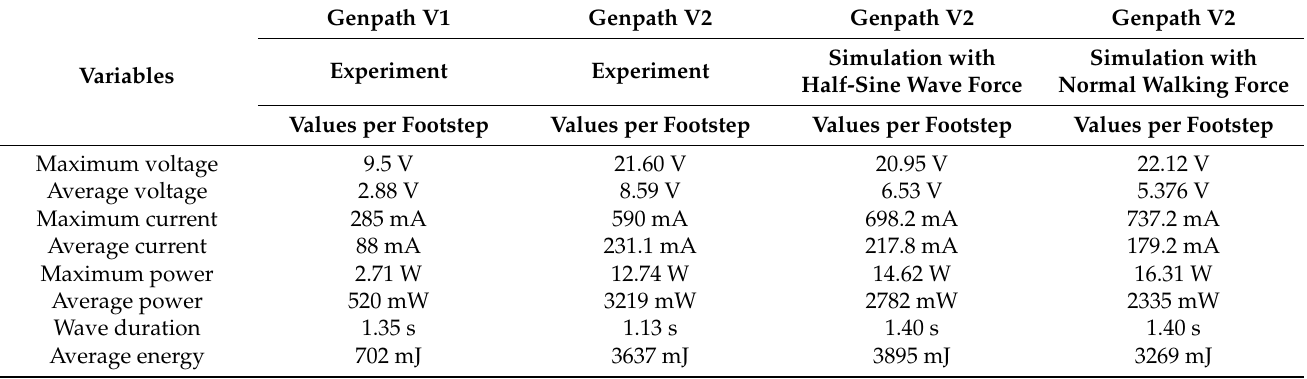
Figure 11. Voltage, current, power, and energy of the Genpath V2 from experiment and simulation when 𝐾 = 1700 N/m: ( a ) voltage and current of the Genpath V2. ( b ) power, and energy of the Genpath V2. Table 6. Performances of the Genpath V1 [24] and the Genpath V2 when K = 1700 N/m